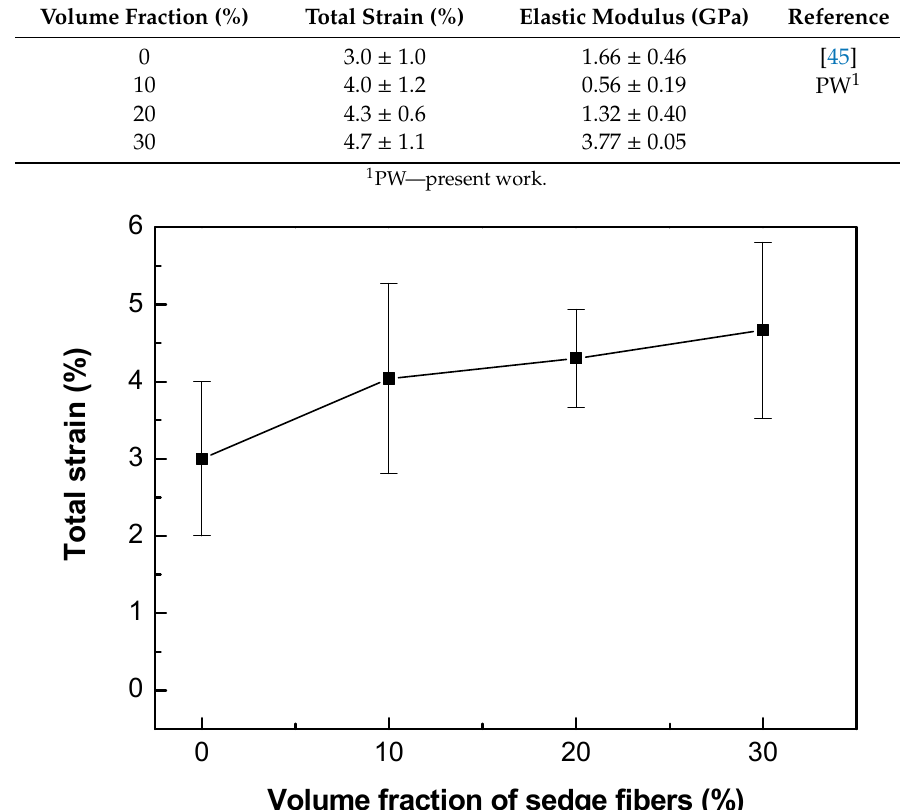
Figure 7. Total strain as a function of the fiber fraction for the neat epoxy resin and CM sedge fiber-reinforced composites.